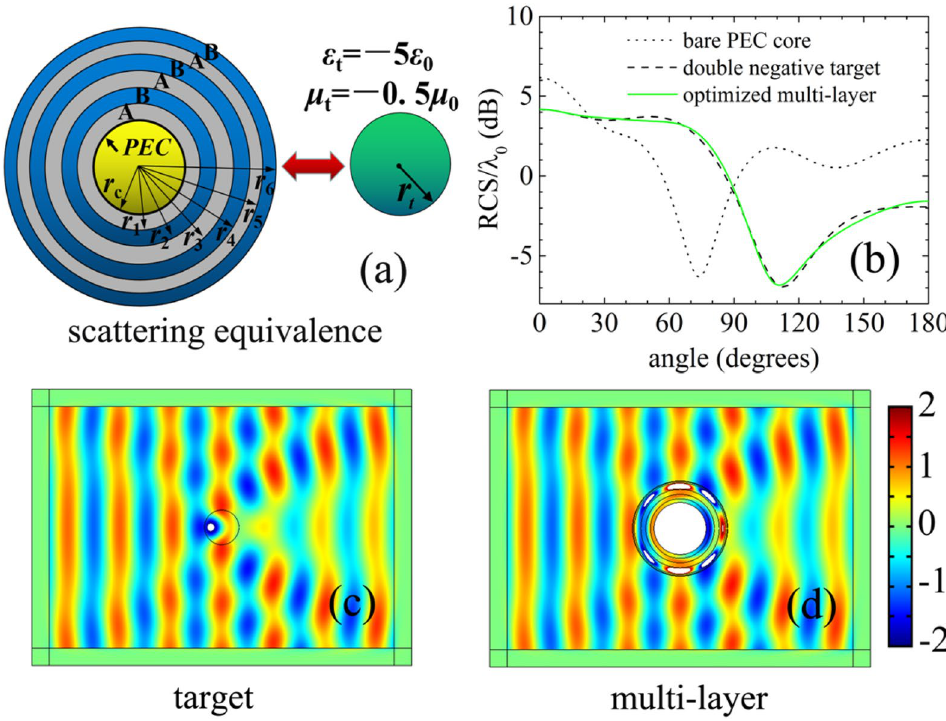
Figure 4. (a) Schematic diagram of scattering equivalence. A PEC core ( r c = λ 0 / 2) covered by an optimized 6-layer shell can be disguised as a target with double negative material ( r t = λ 0 / 3, ε t = -5 ε 0 , μ t = -0.5 μ 0 ). (b) The scattering widths normalized by wavelength for the bare PEC core (dotted black line), the double negative target (dashed black line), and the optimized design (solid green line). The magnetic field distributions of the double-negative-material target (c) , and the optimized 6-layer illusion device (d) are simulated using COMSOL Multiphysics. The magnitudes out of the colour bar range are represented by white